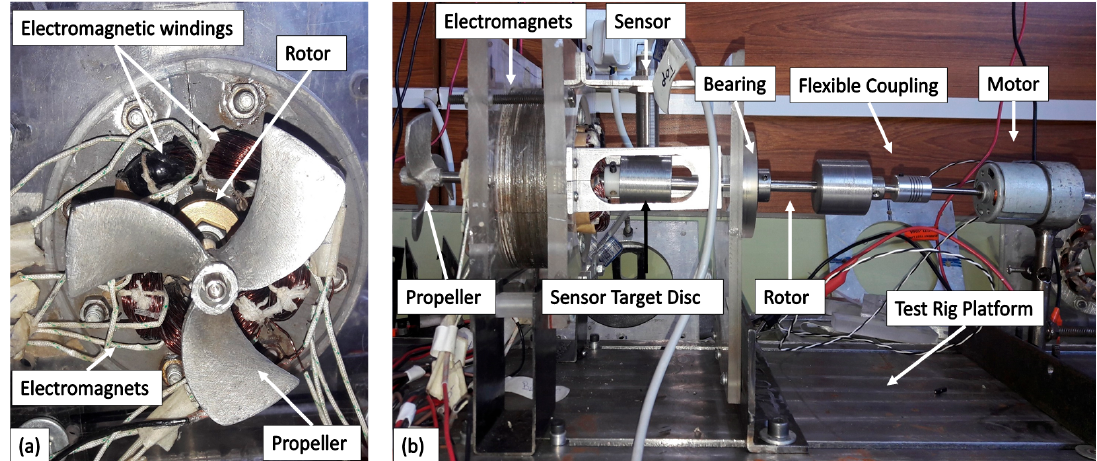
Figure 10. Experimental setup of AMB system, ( a ) Front view and ( b ) Side view.